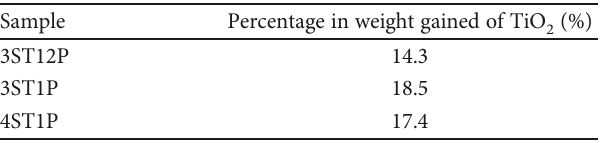
Figure 8: SEM image of TiO Table 3: Final percentage in weight gained of TiO monoliths.